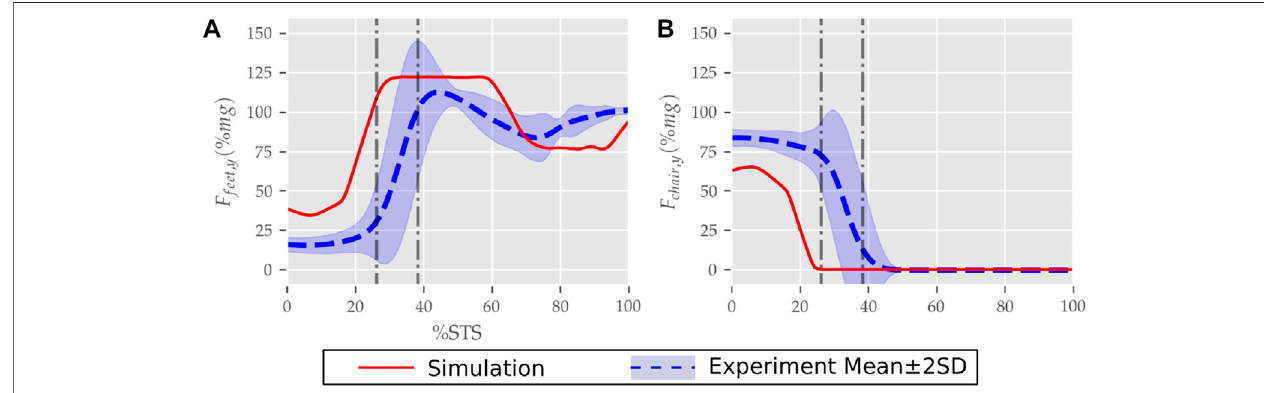
FIGURE 10 | (A) Feet and (B) seat contact forces observed during the STS trajectory of the 0% strength de fi cit model and the experiments.